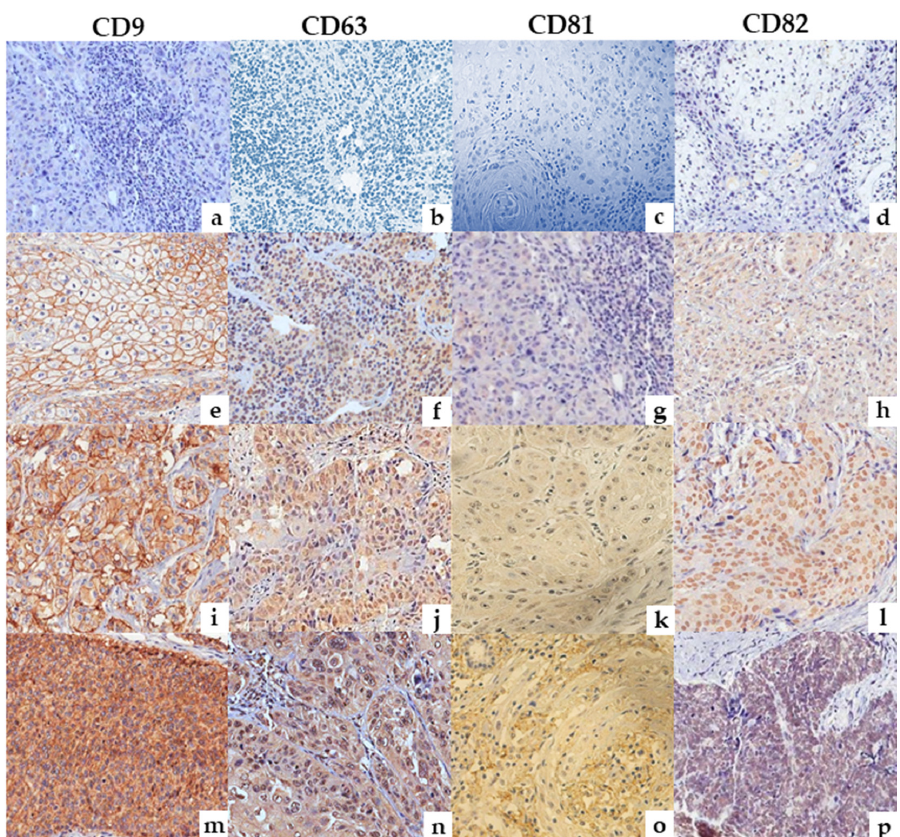
Figure 2. Representative photomicrographs of IHC reactions for CD9, CD63, CD81, and CD82. The pattern of staining was categorized as negative ( a – d ), weak ( e – h ), moderate ( i – l ), and strong ( m – p ) reactions (original magnification, × 40), considering membrane and/or cytoplasmic positivity. Table 2. Frequency of TSPANs immunohistochemical positive staining (moderate and strong) in VSCC samples ( n = 117). Statistically, the comparison analysis within the protein expression of each TSPAN Target/ showed significant differences between CD63 and CD9 ( p < 0.01), as well as between CD9 and CD81 ( p < 0.0001, Figure 1c). Robust statistical differences were also found among the